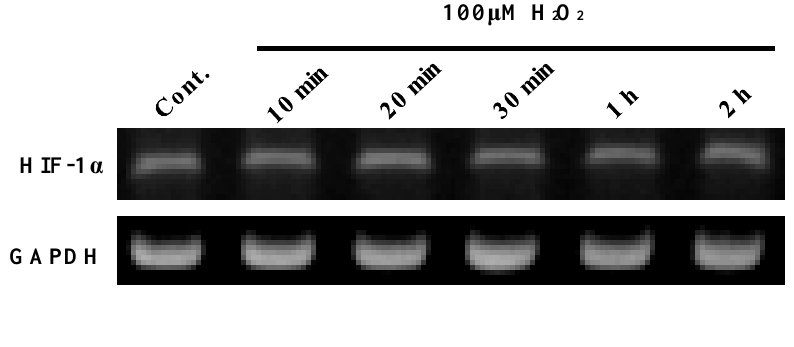
Figure 8. HIF-1  mRNA expression in THP-1 cells as a function of various incubation times of ROS. A representative RT-PCR experiment showing HIF-1α expression in THP-1 cells treated with 100 μM H were treated with 100 μM H harvested and examined by